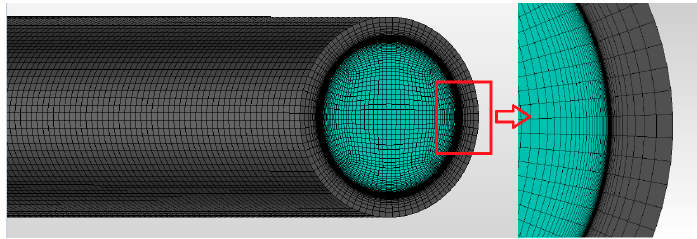
Figure 13. Mesh generation of the domain and near-wall